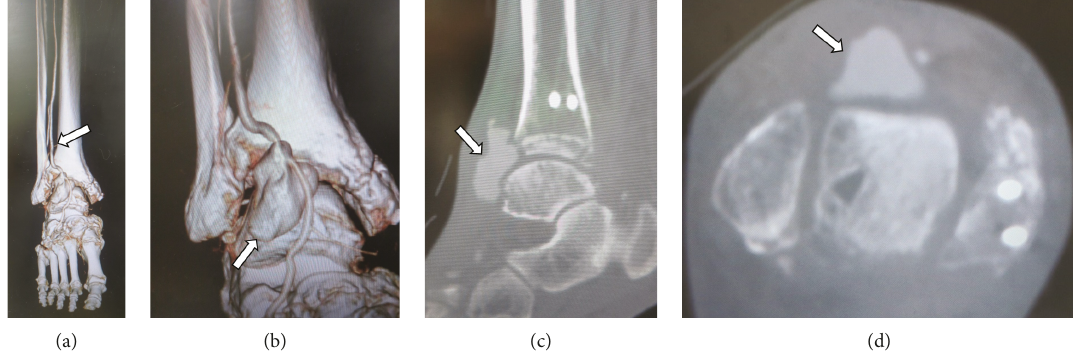
Figure 3: Enhanced three-dimensional computed tomography (CT) images show the perforating peroneal artery (arrow) with the absence of the anterior tibial artery and posterior tibial artery (a) and the pseudoaneurysm of the perforating peroneal artery (arrow) at the lateral aspect of the ankle joint (b). Enhanced CT images also show the size of the pseudoaneurysm (arrow) 15 × 20 × 30mm on the sagittal (c) and axial planes (d).